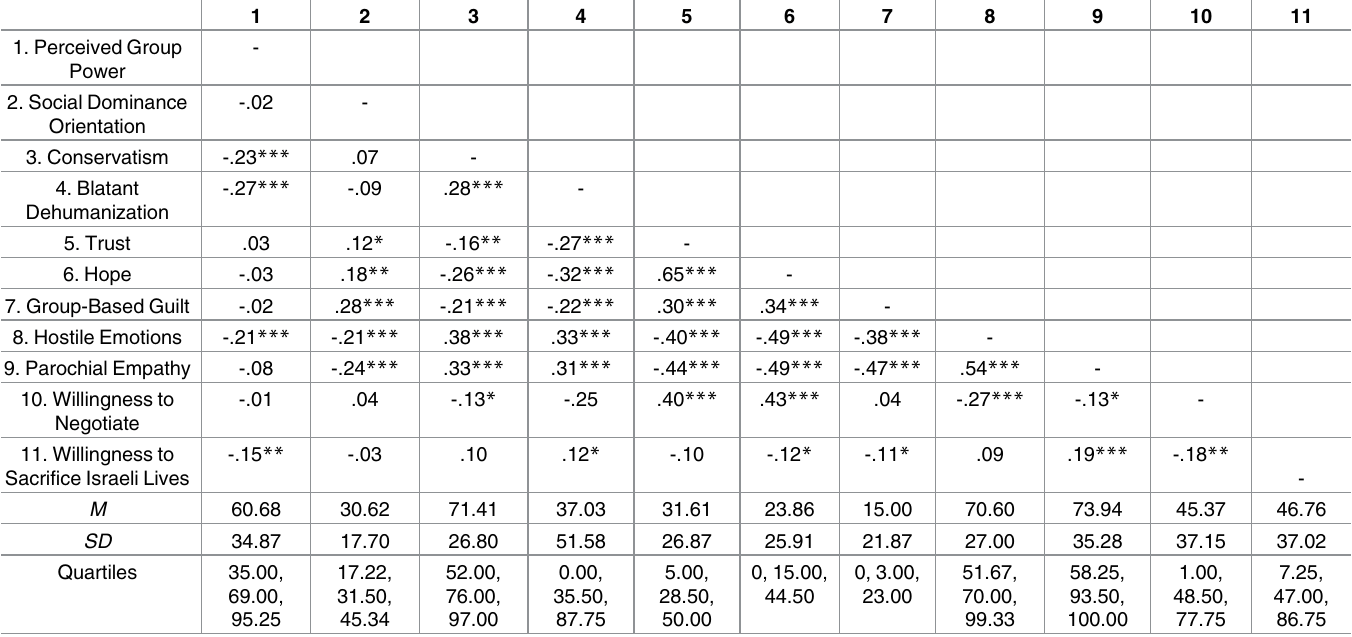
Table 3. Descriptivestatistics and variable intercorrelations for Study